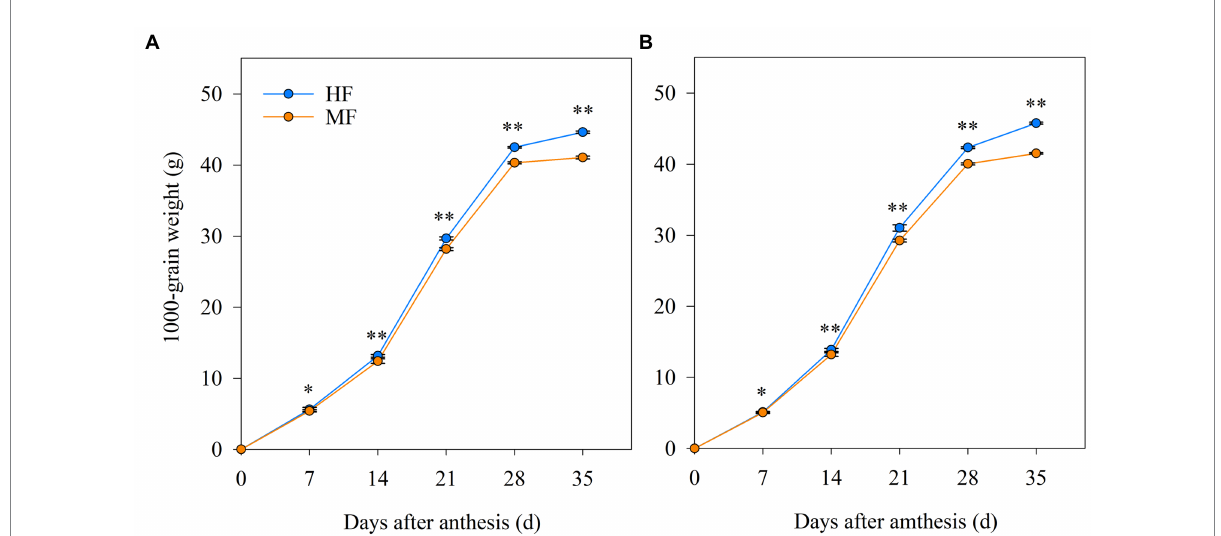
FIGURE 6 The 1,000-grain weight after anthesis in 2017/18 (A) and 2018/19 (B) growing seasons. HF, high soil fertility field and MF, middle soil fertility field. Vertical bars represent SD of the means. * p < 0.05 and ** p < 0.01.